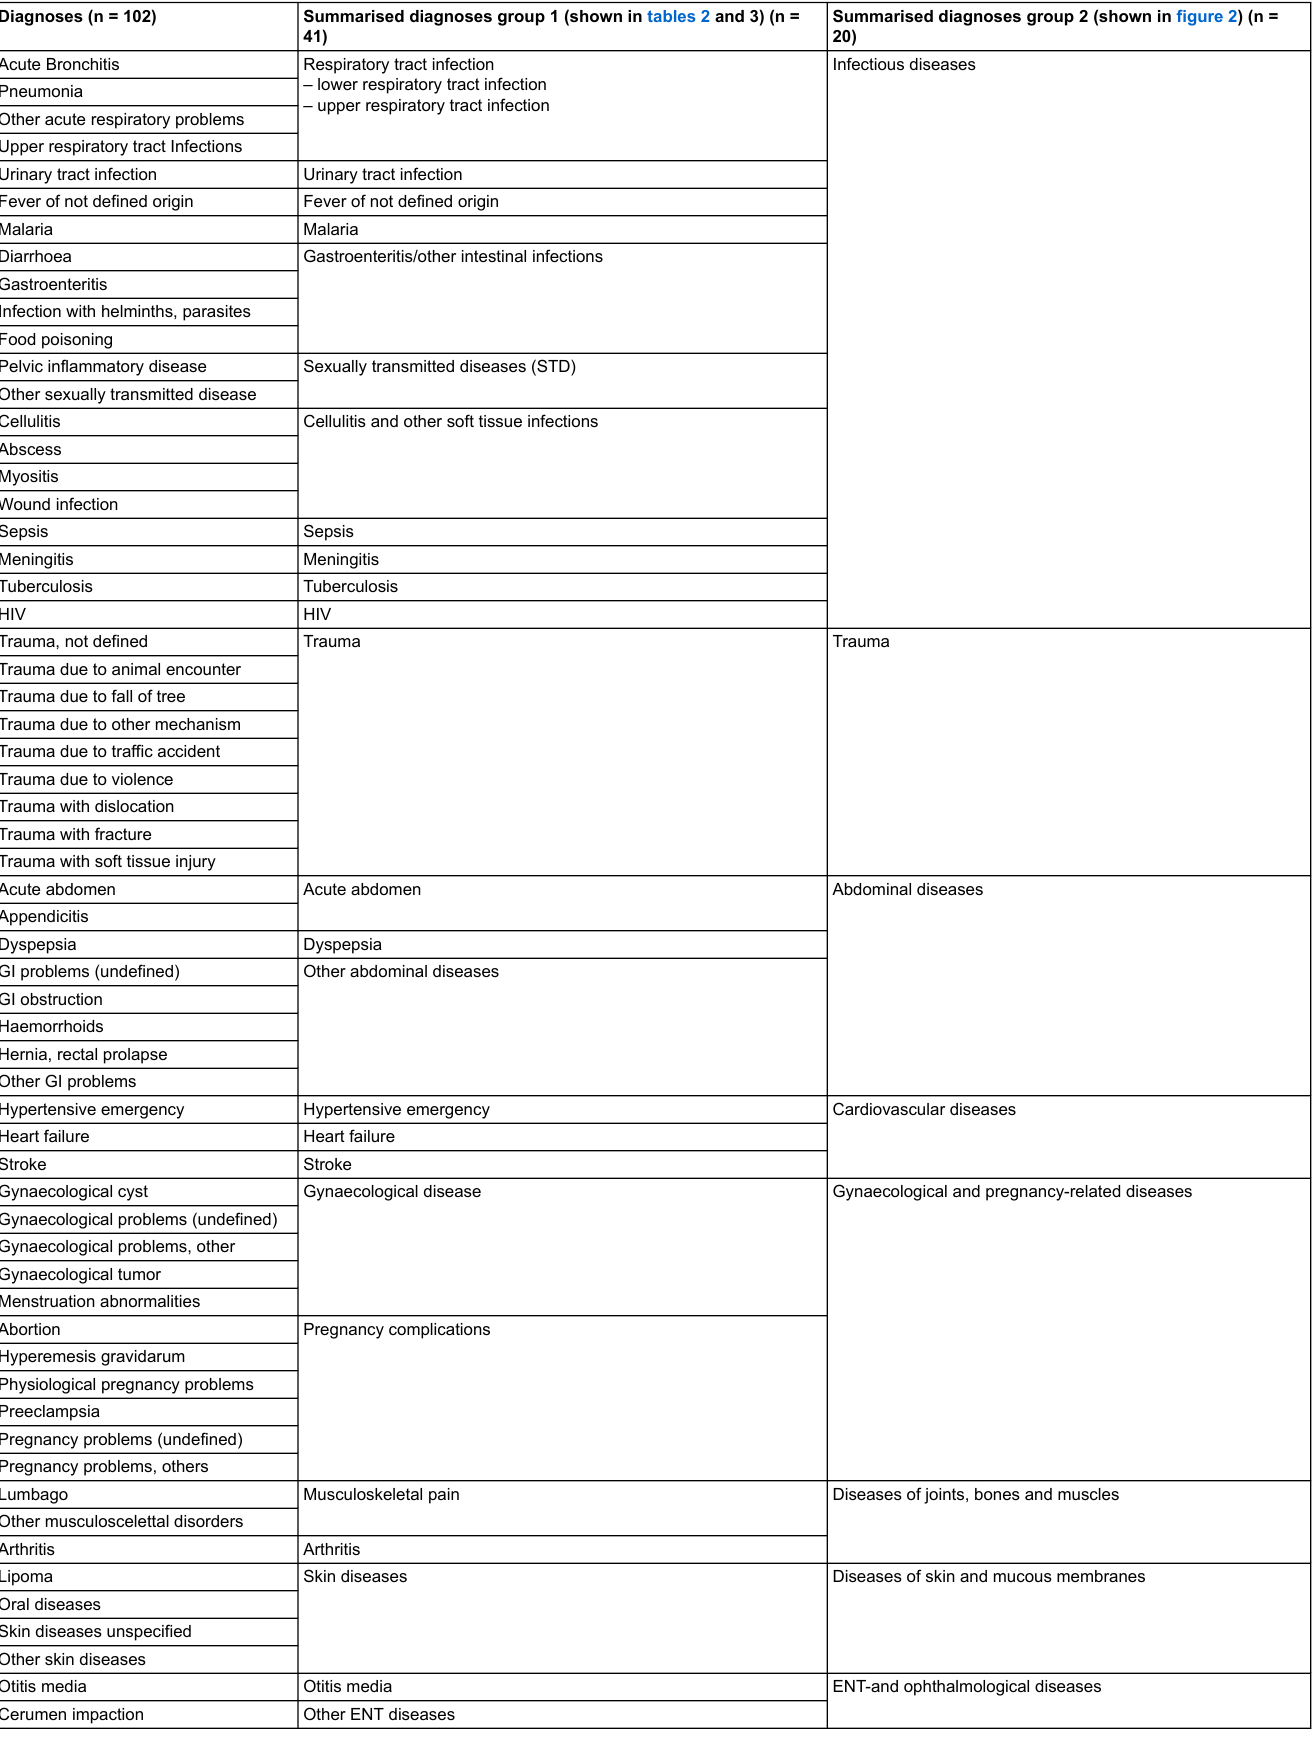
Table S1: Classification of diagnoses Diagnoses (n =